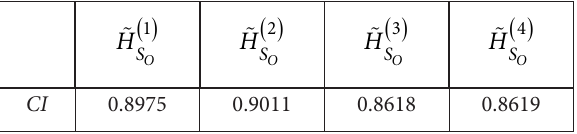
Table 6. The consistency index of each DHHFLPR